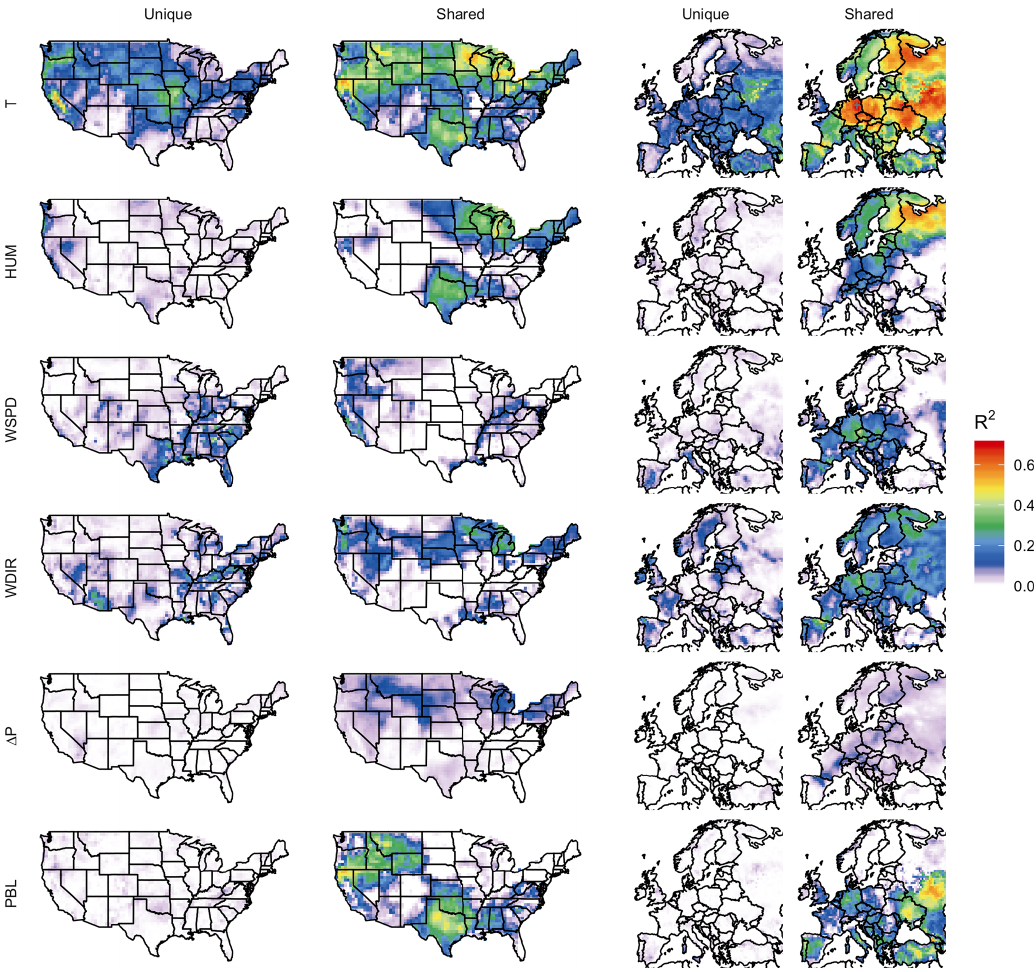
Figure 6. Unique and shared O 3 correlation among meteorological variables in the BASE case. Unique contributions represent predictive power provided by one meteorological covariate alone, while shared correlation could be attributed to one or more other